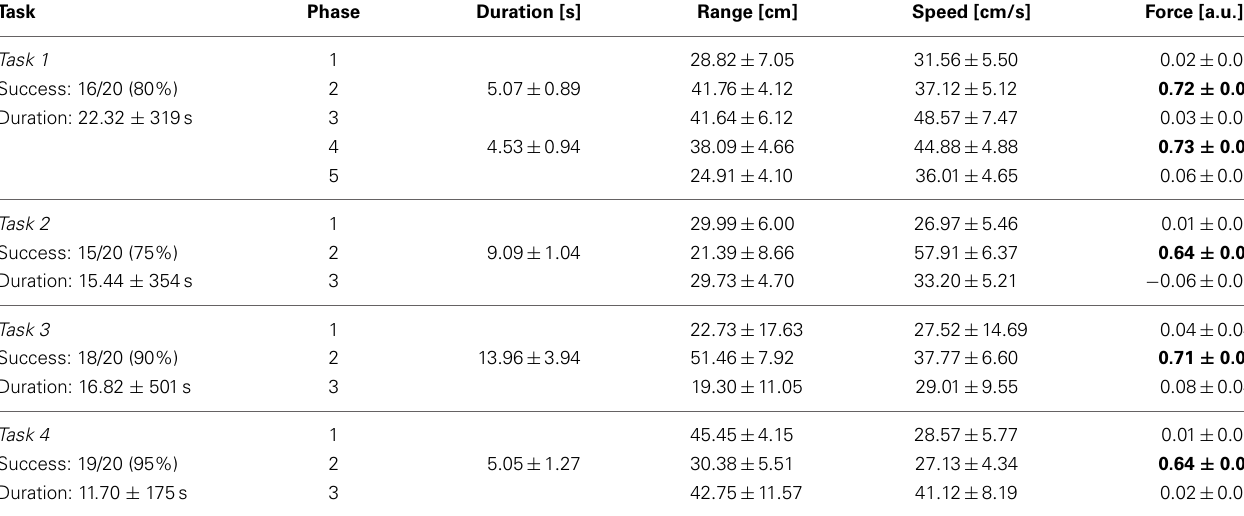
Table 1 | The success rate and duration for all four tasks and the duration, motion range and speed, and grasping force (in arbitrary units) for each phase of each